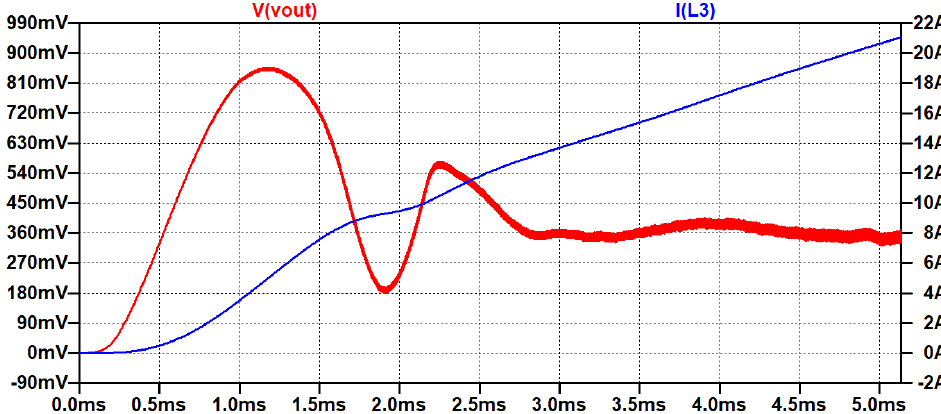
Figure 14. The output voltage and current response of the circuit with GaN switch and LC load.